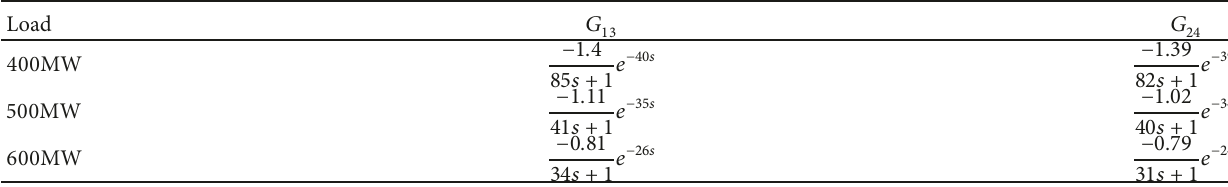
Table 3: The model of spray desuperheating-reheat steam temperature under 400 MW, 500 MW, and 600 MW.